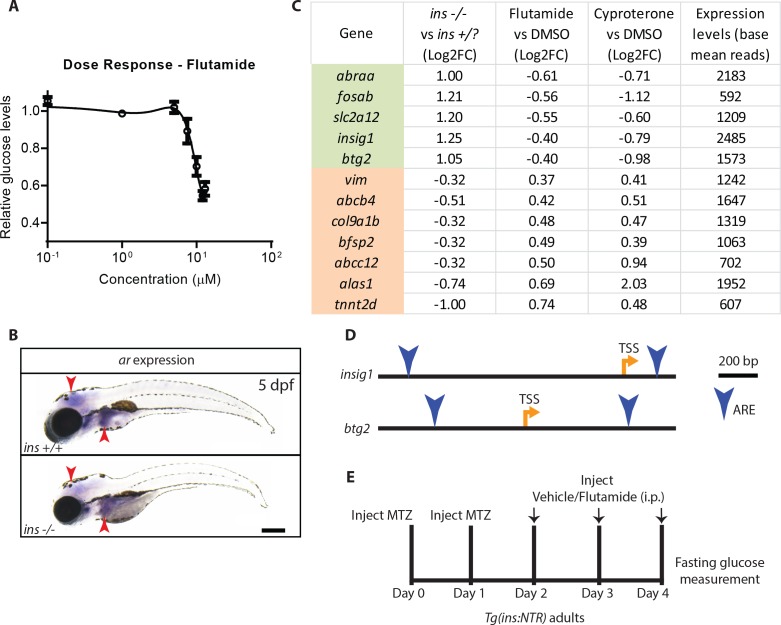
Flutamide reduces glucose levels in a dose-dependent manner, possibly exerting its effects through liver gluconeogenic enzymes.(A) Dose response curve of the glucose lowering effect of flutamide in ins mutant larvae, treated from 84 to 120 hpf; mean ± SEM, n = 3 replicates. (B) Wholemount in situ hybridization for ar expression in 120 hpf wild-type and ins mutant larvae showing signal in the brain and liver (red arrowheads). (C) The 12 genes differentially regulated in ins mutants compared to non-mutant siblings and modulated in the opposite direction upon treatment with flutamide or cyproterone compared to DMSO; listed with their fold change (Log2 scale) and expression levels under control condition (base mean reads); genes are ordered by the fold change in the flutamide vs DMSO condition. (D) Schematic of insig1 and btg2 gene loci, with location of transcription start site (TSS) and androgen response elements (ARE, blue arrowheads). (E) Schematic of vehicle vs flutamide treatment of Tg(ins:NTR) adult animals following β-cell ablation with metronidazole (MTZ) injection to induce hyperglycemia. Scale bar: 250 μm.